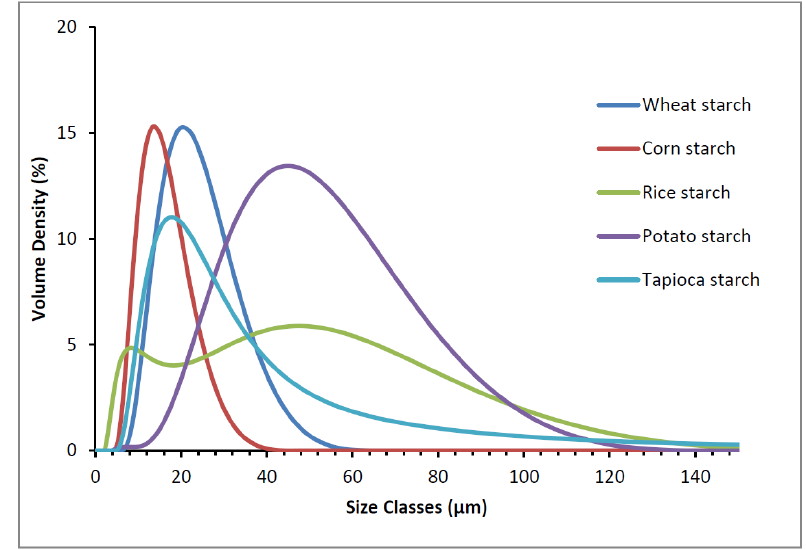
Figure 2. Granule size distributions of the different starches.